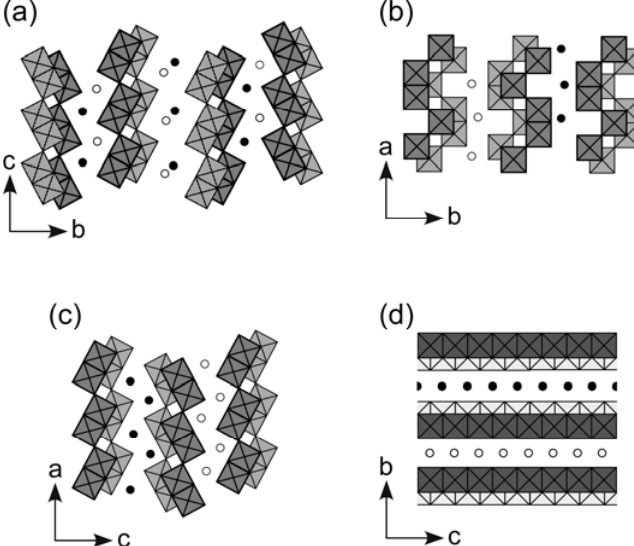
Figure 5. Crystal structure of layered niobate and titanates that have intercalating reactivity and semiconductor photocatalytic activity: (a) K HTiNbO , and (d) H Ti O . Squares and circles indicate NbO 5 1.07 1.73 4 form oxide layers and interlayer exchangeable cations (K + or H + ), respectively.